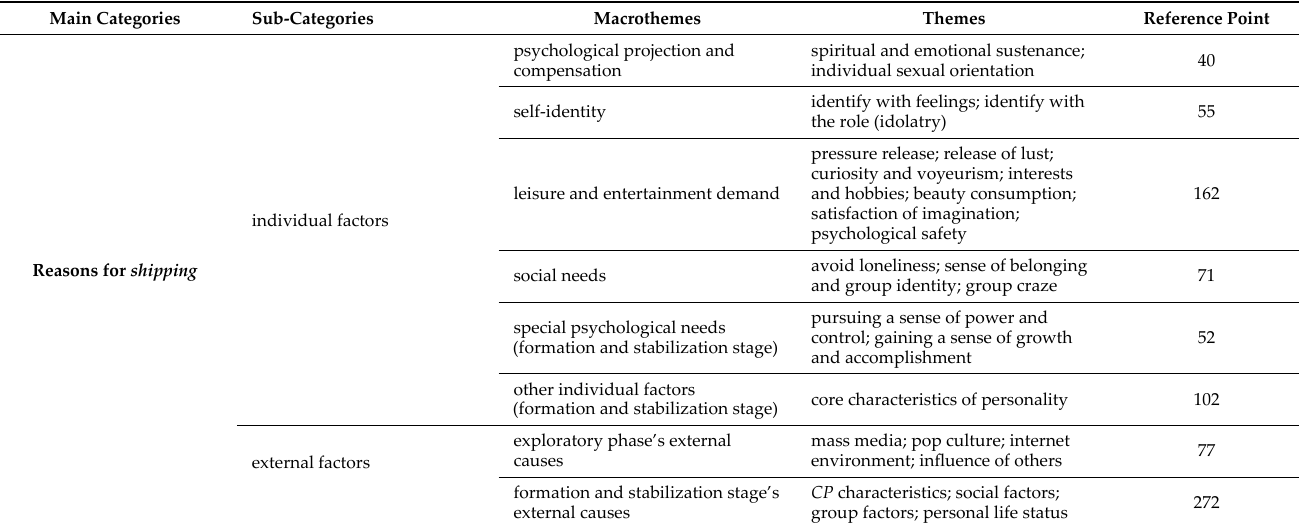
Table 2. Three categories of shipping